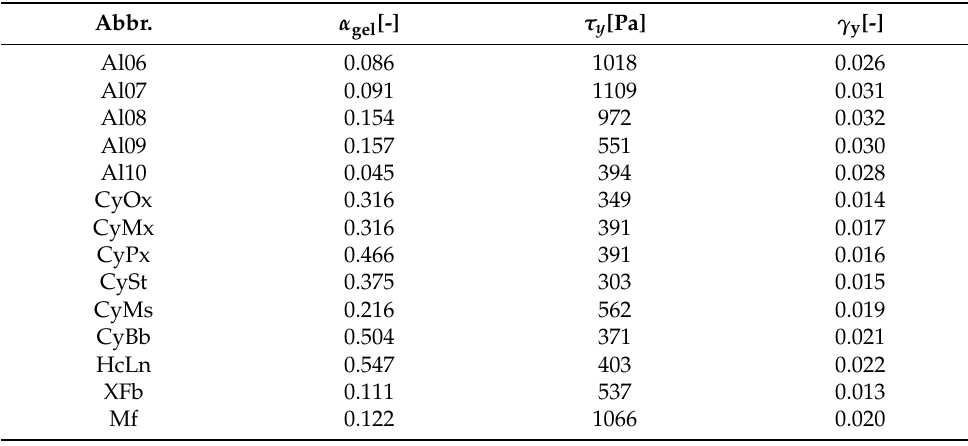
Table 3. Property of 12HSA organogels obtained at w = 1.0 wt%.